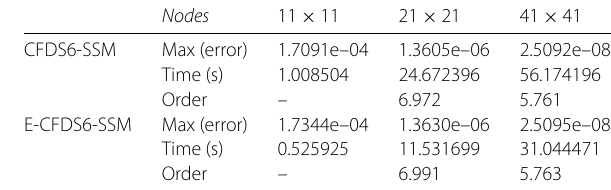
Figure 9 The error between the solution of CFDS6-SSM and solution of E-CFDS6-SSM when J = 41 and t = 2 for SP